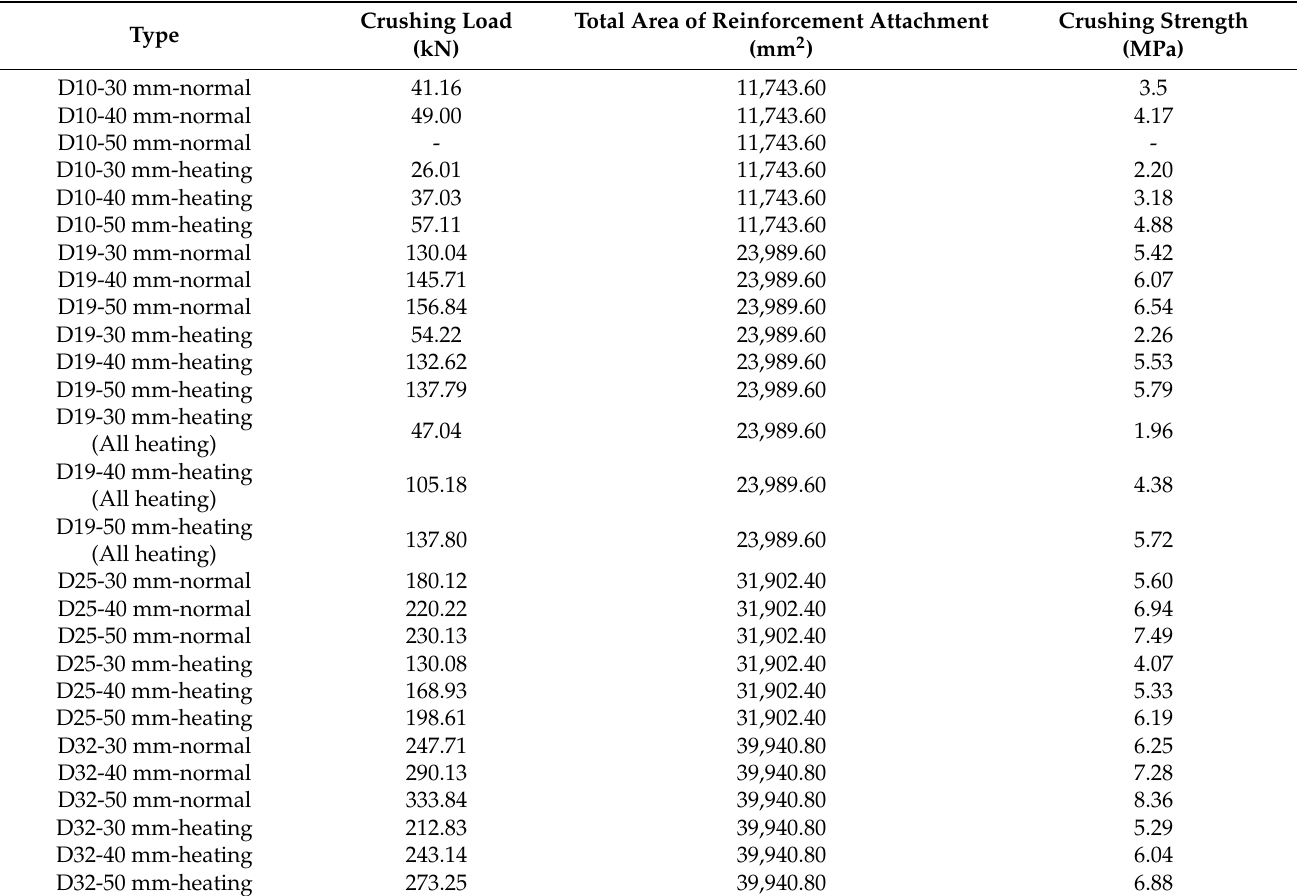
Table 7. Calculation details of rebar adhesion